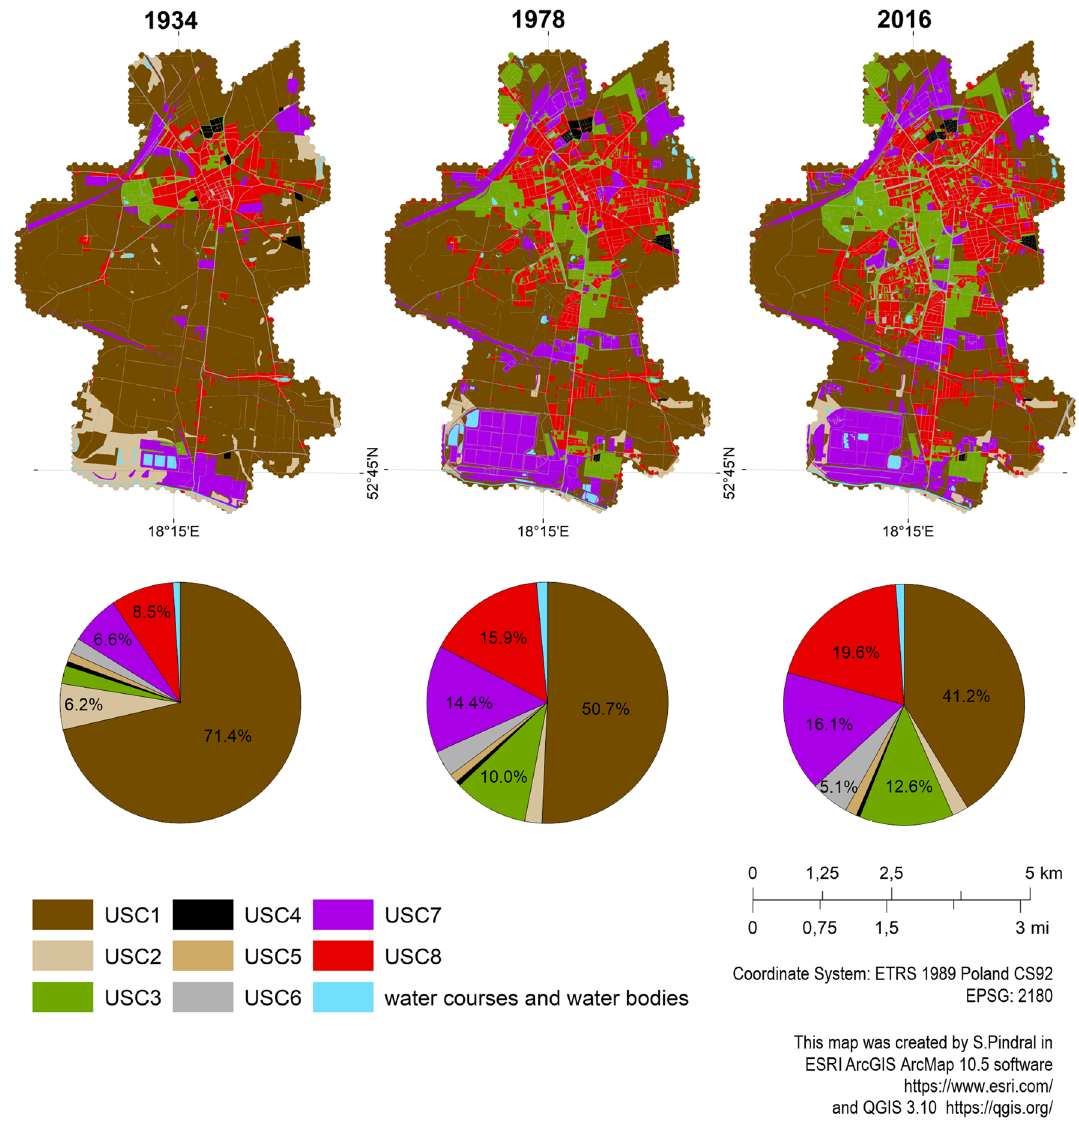
Figure 3. Maps of urban soil complexes (USCs) for selected